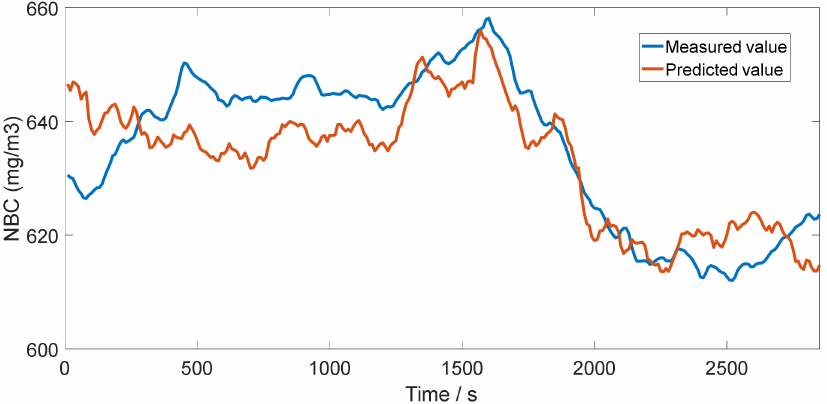
Figure 5. Trend of actual and predicted NO X value of 12,000 t / d production line.